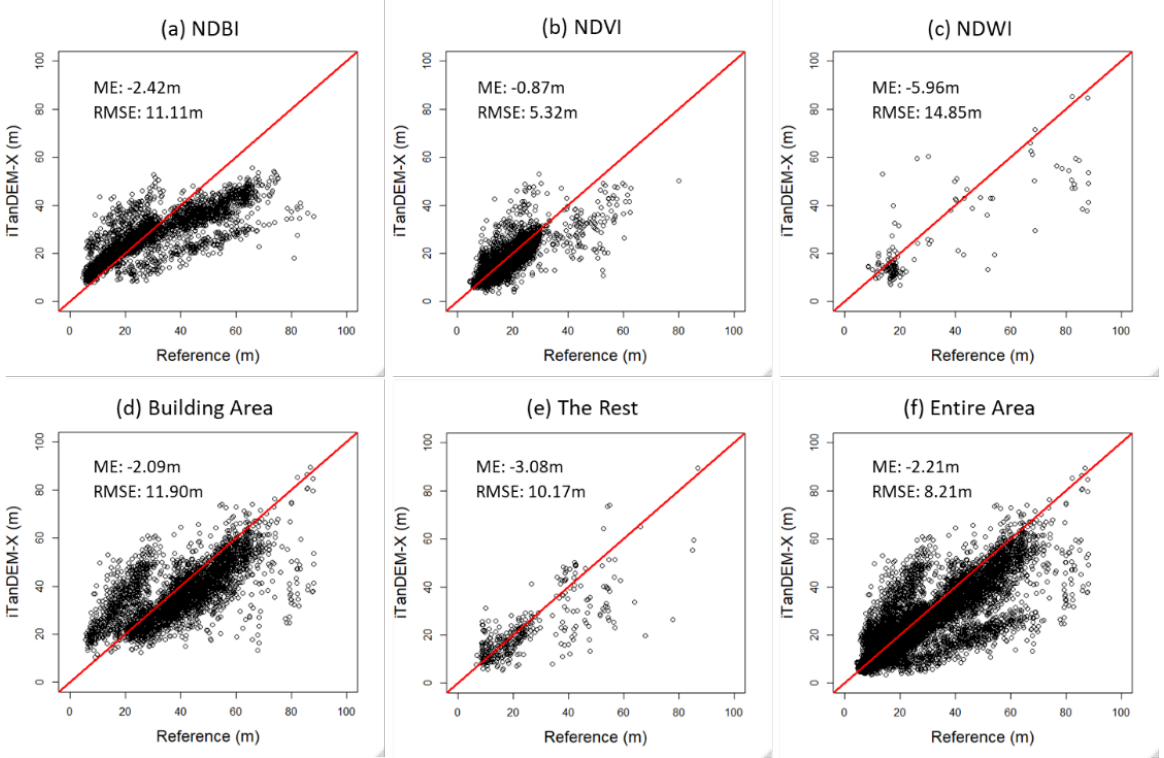
Figure 7. Scatterplots of iTanDEM-X vs. reference DEM and performance measures ME and RMSE: different land covers in Singapore: ( a ) NDBI, ( b ) NDVI, ( c ) NDWI, ( d ) Building Area, ( e ) The Rest, ( f ) The Entire Area.